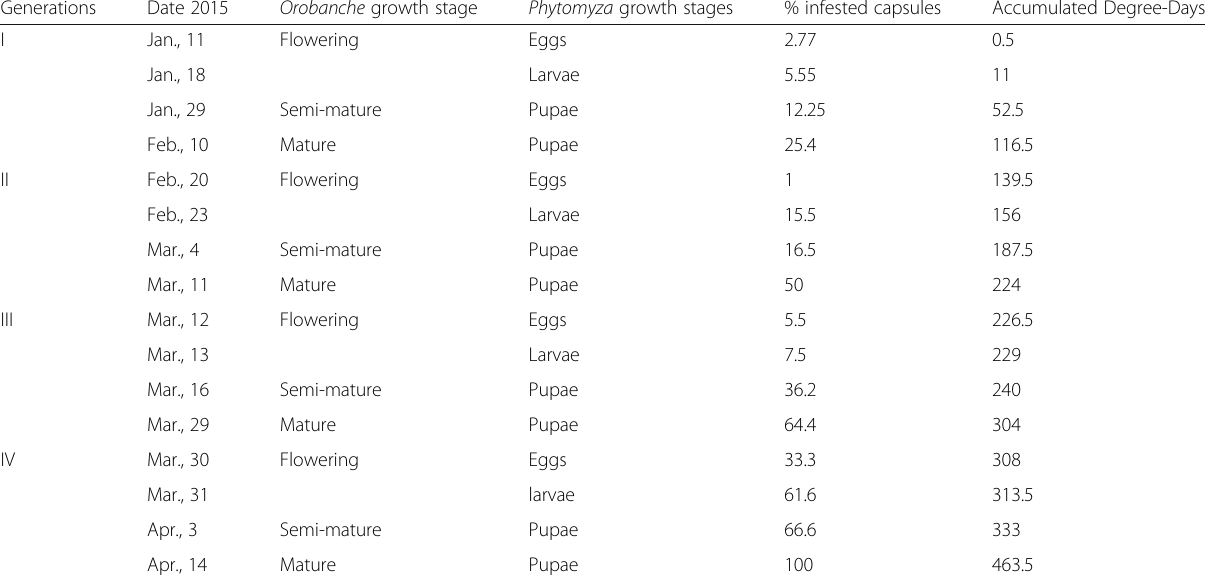
Table 1 Develoment of Phytomyza. orobanchia generations synchronized with three growth stages of Orobanche crenata spikes in Alexandria region